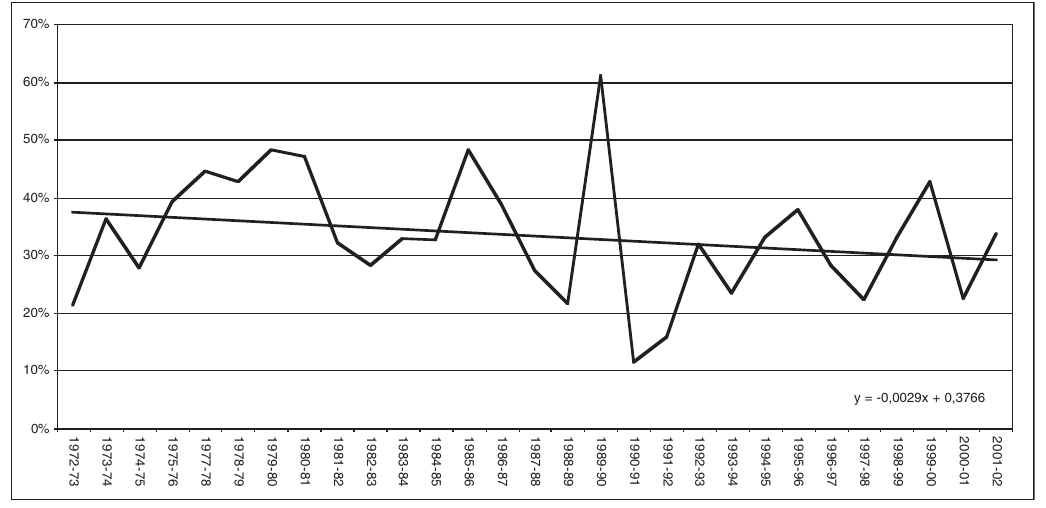
Figura 3 – Le prime 3 contro le ultime